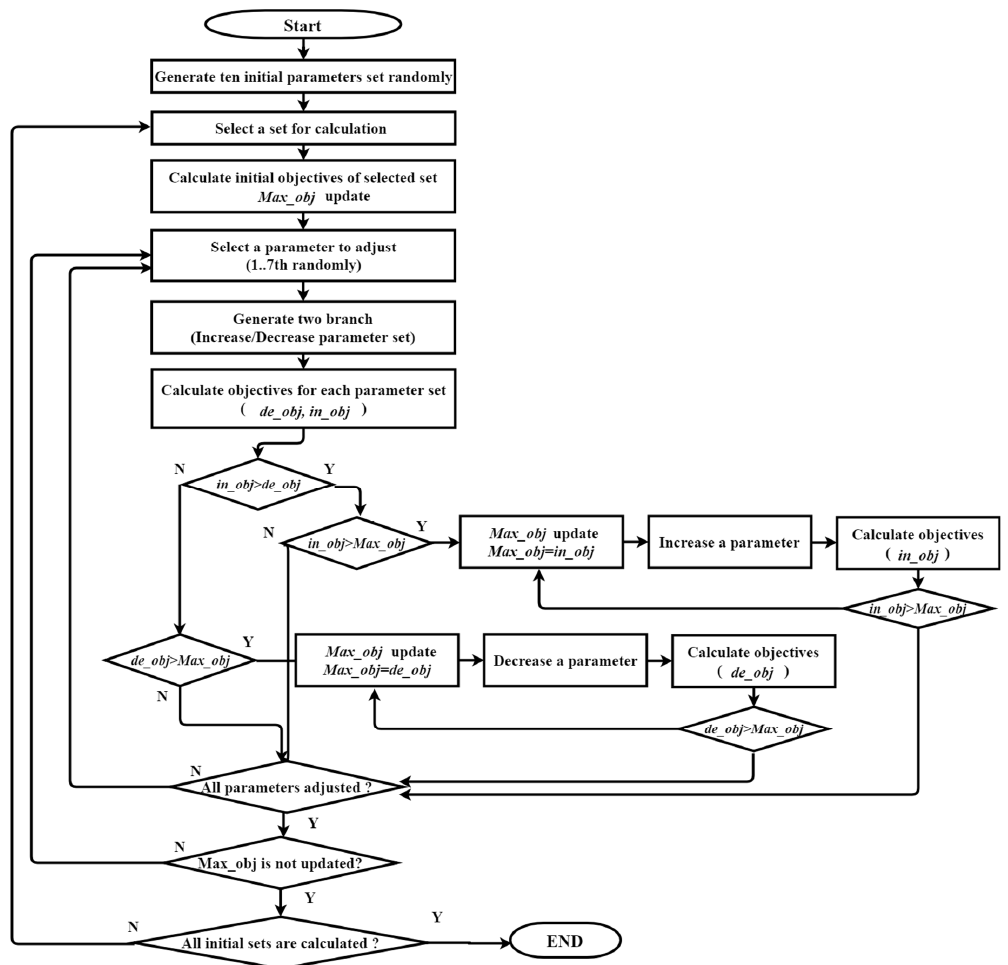
Figure 15. flow chart of optimal parameter estimation using branch-and-bound algorithm. Figure 15. Flow chart of optimal parameter estimation using branch-and-bound